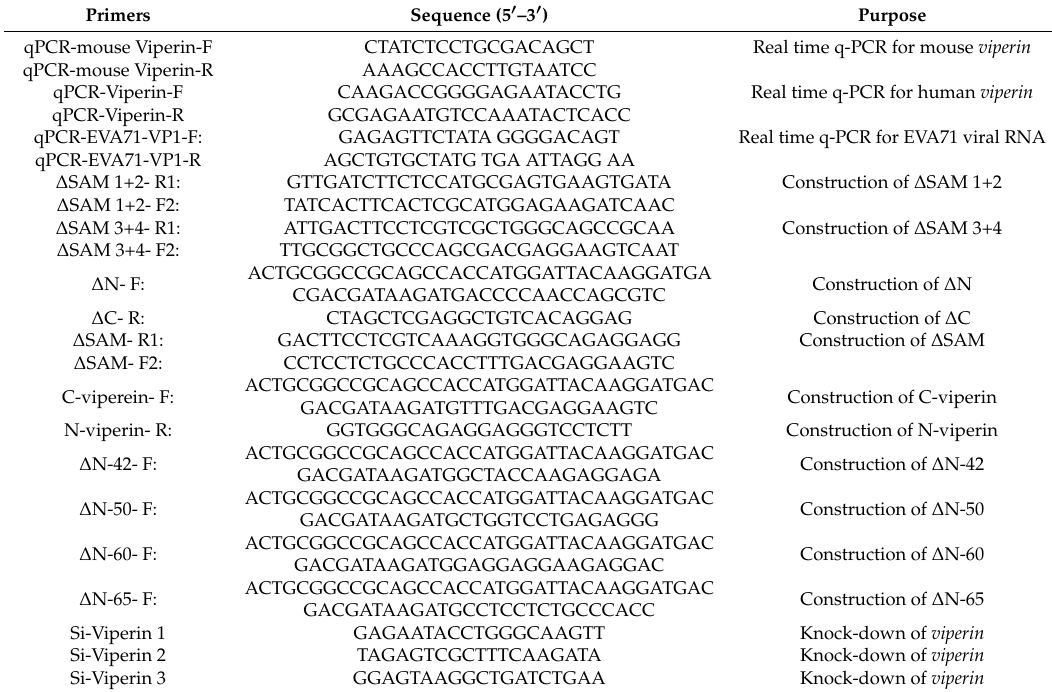
Table 1. Primer and siRNA sequences used in the